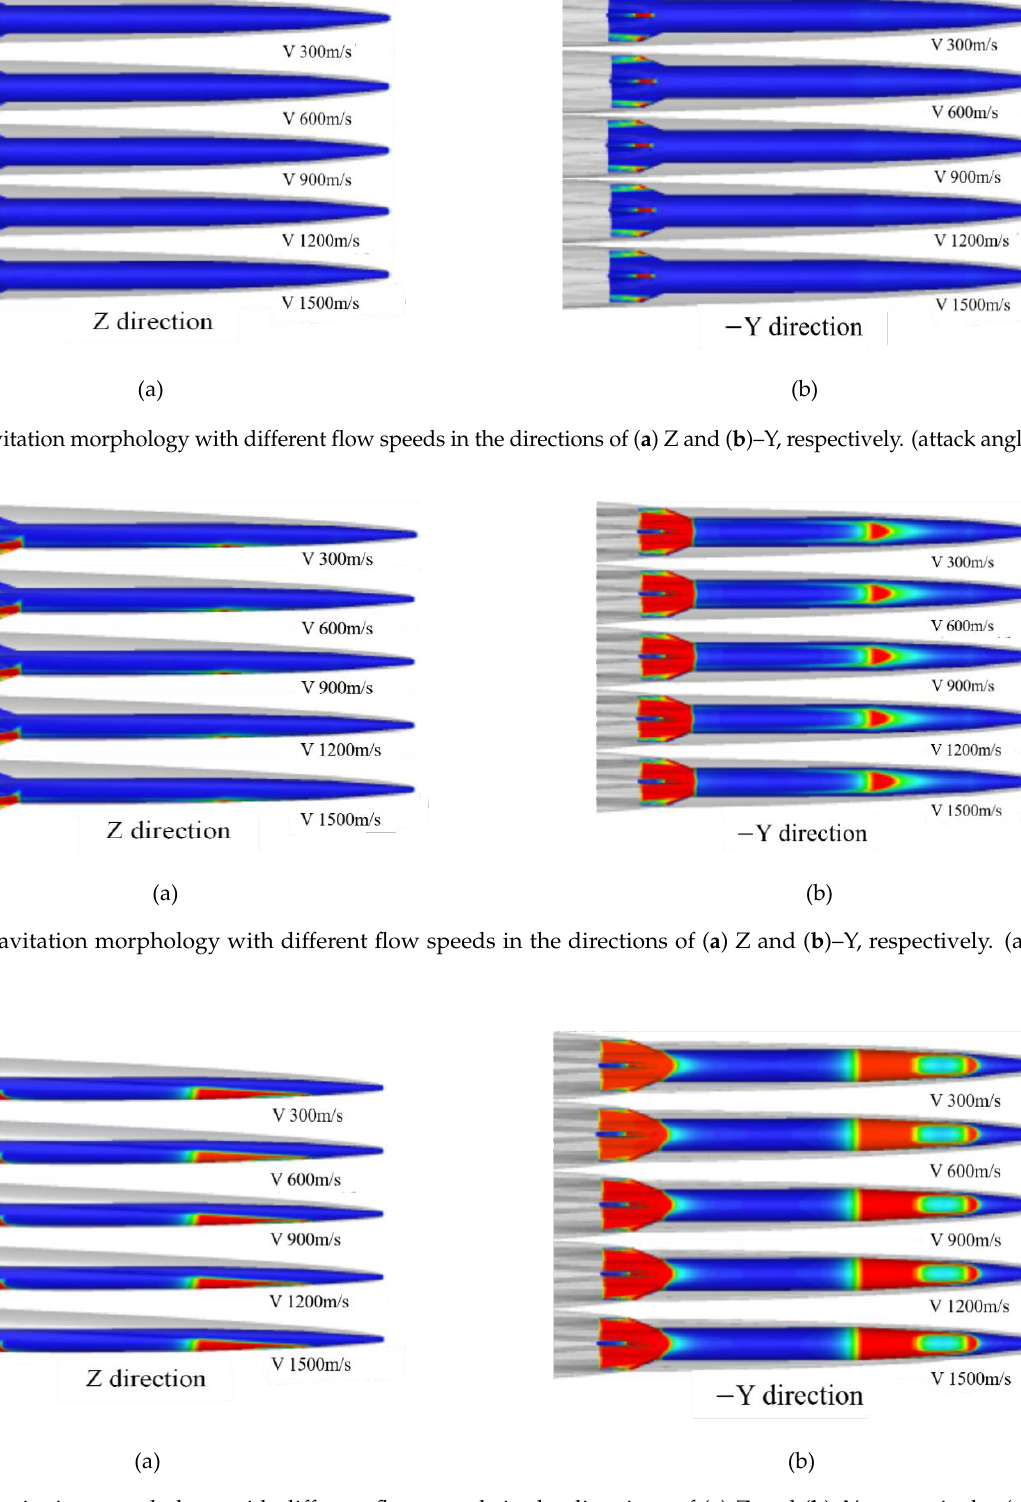
Figure 11. Cavitation morphology with different flow speeds in the directions of ( a ) Z and ( b ) – Y, respectively. (attack angle 3°).